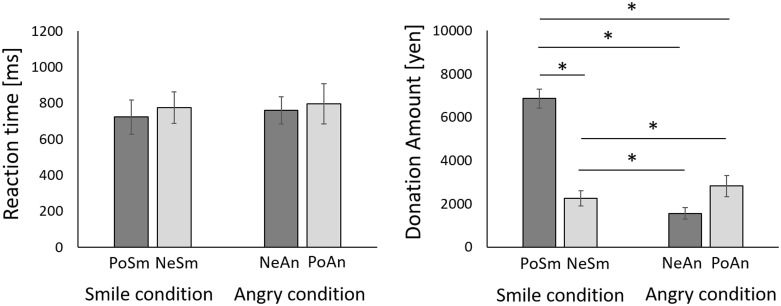
Comparison of reaction times and donations in each condition.Donations for PoSm are significantly greater than those for NeSm conditions. Asterisks in the figure denote significant differences.